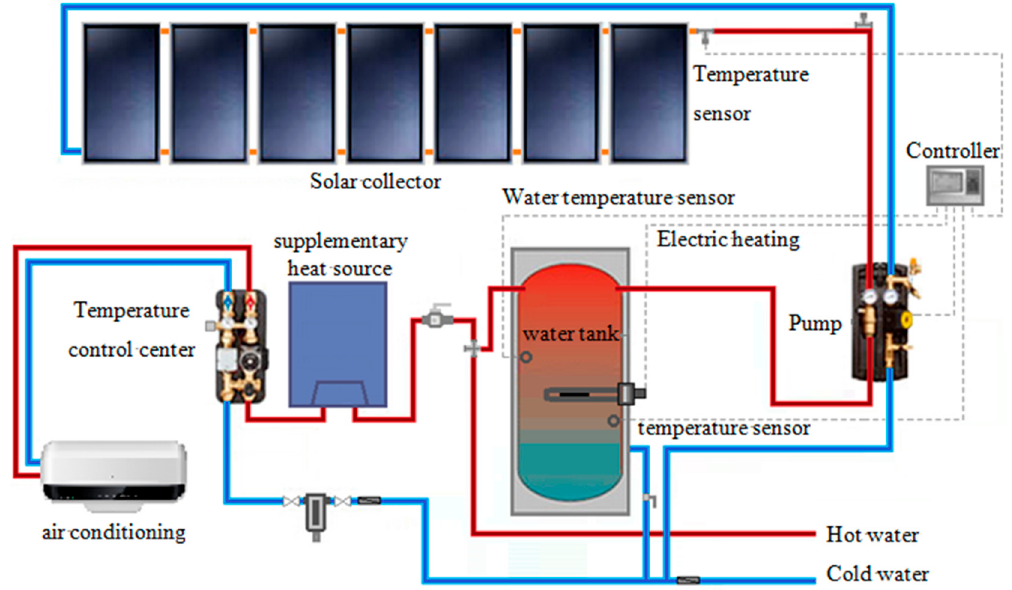
Figure 7. Schematic of the solar collector based hot water generation and refrigeration system.